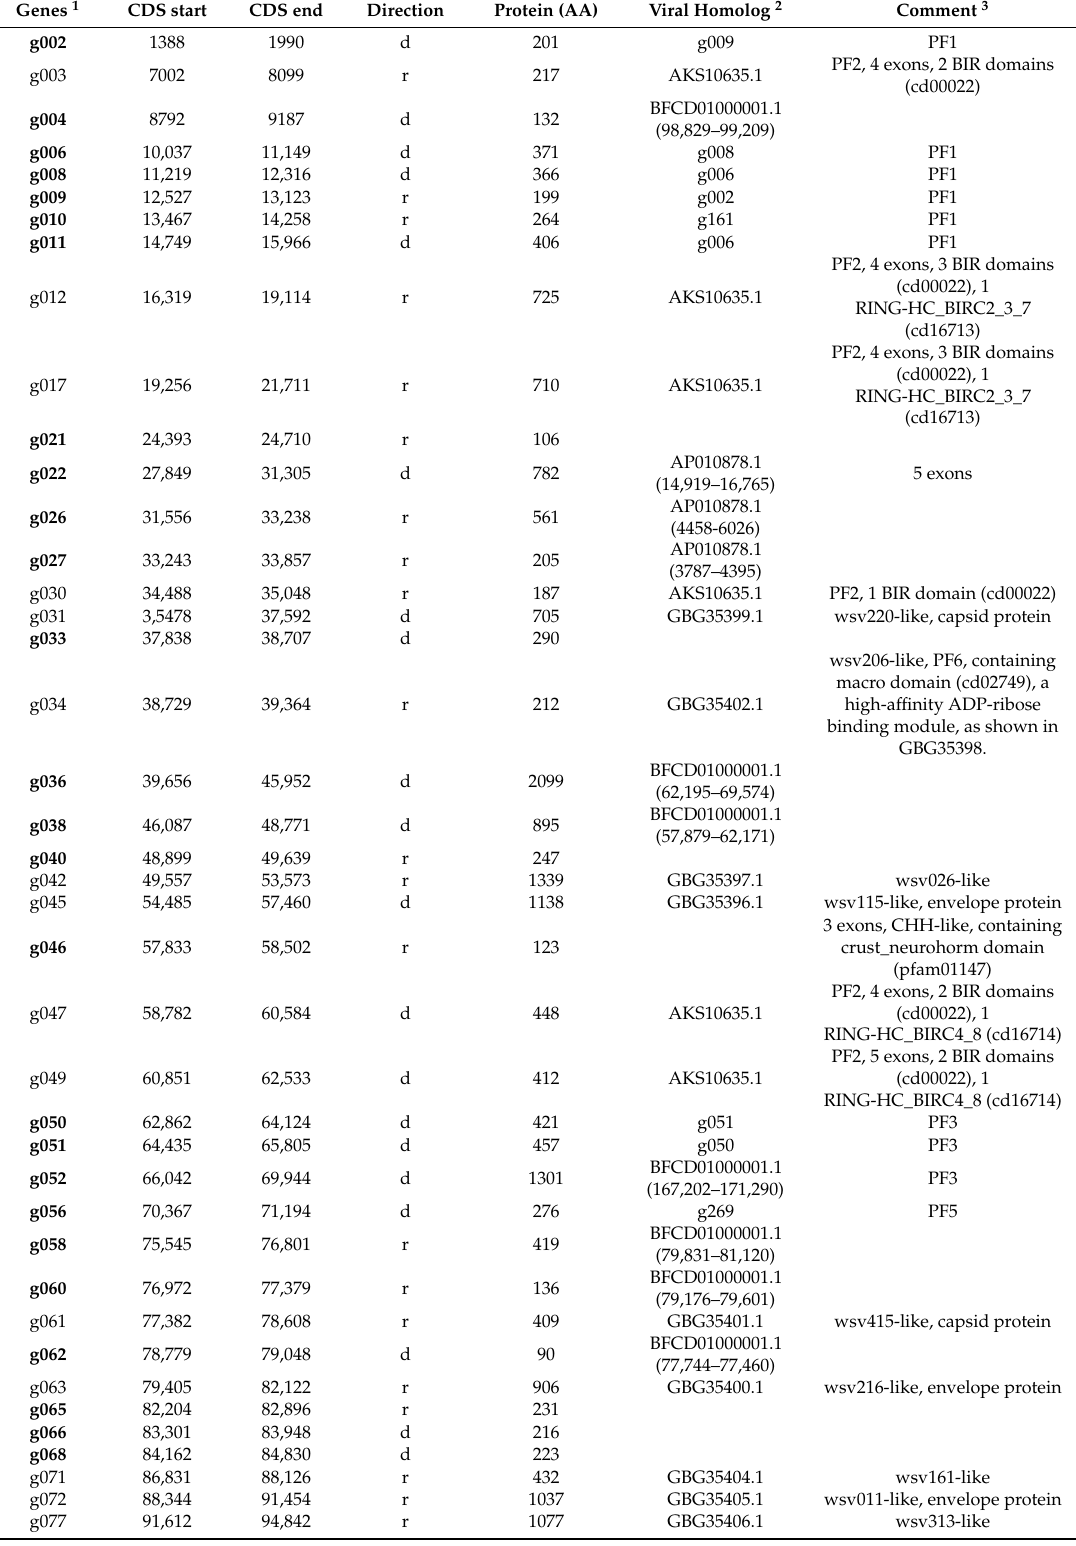
Table 3. A total of 117 protein-coding genes predicted in Nimav-1_LVa endogenous